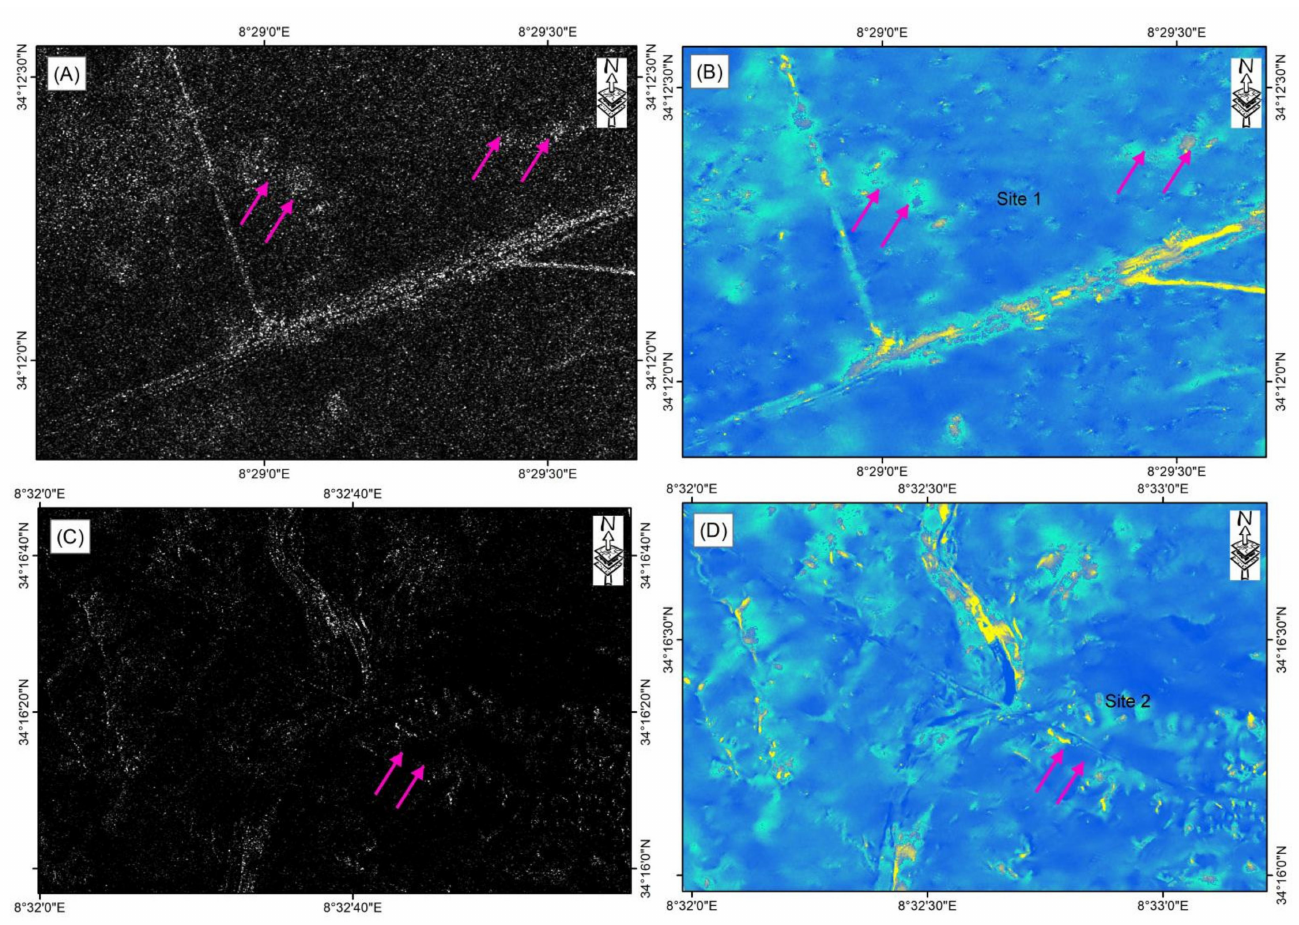
Figure 5. Results obtained with the NL-SAR method involving TSX SL data. ( A , C ) Original TSX intensity SL images acquired on 8 November 2011 (SAR image © DLR, 2011); ( B , D ) anomalies on bare ground observed in an enhanced TSX SL image at a ground resolution of 1.3 m and an incidence angle of 38 ◦ .The pink arrows denote some features of the ancient fortress in the eastern part of the study